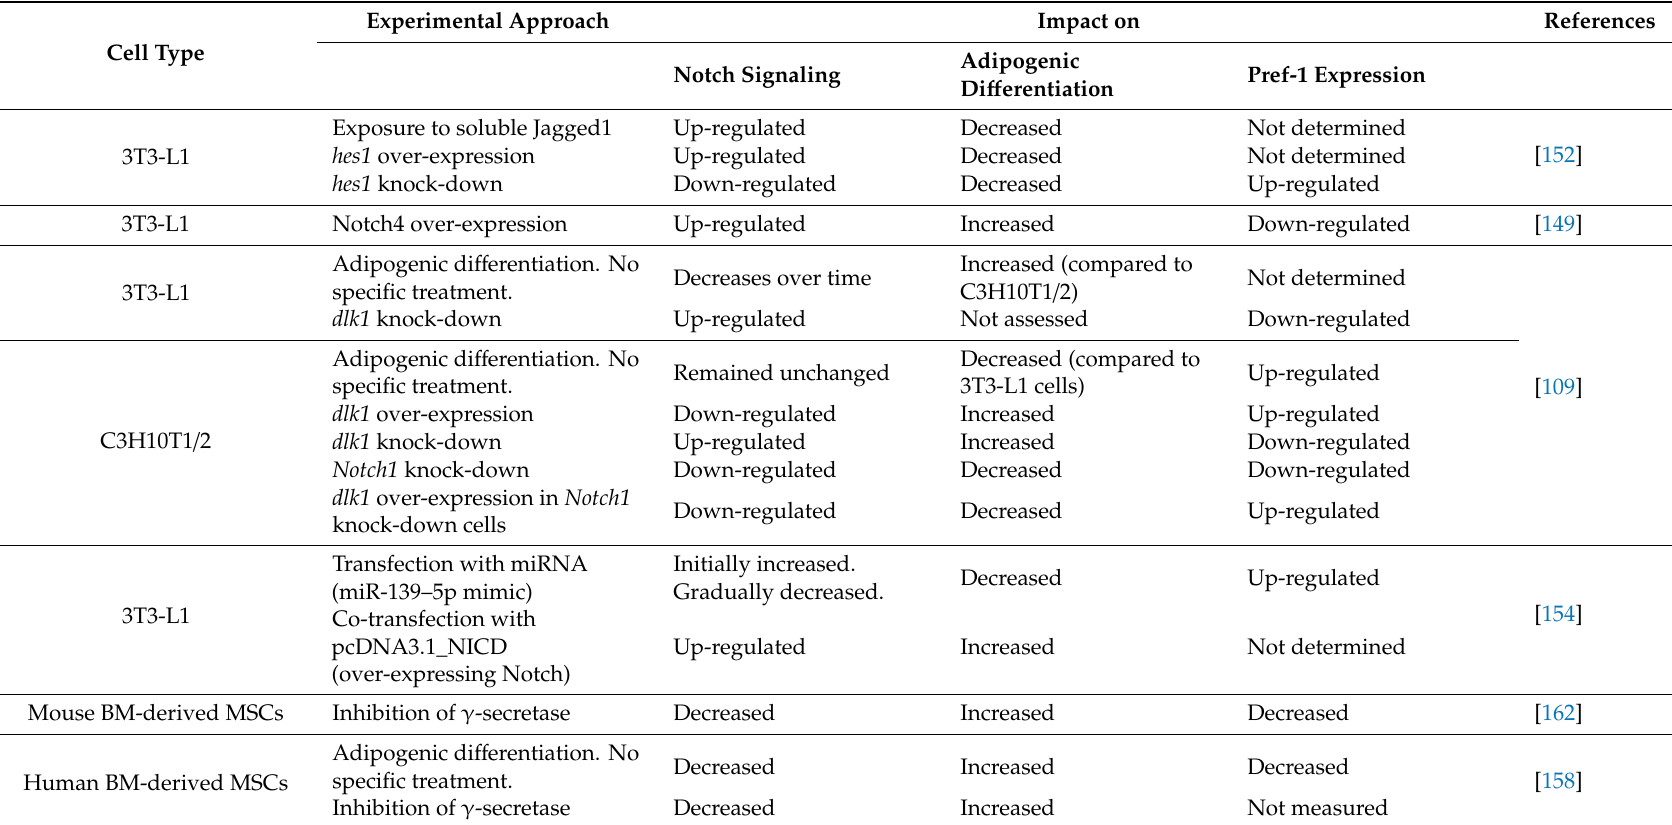
Table 2. Summary of the impact of Notch signaling on Pref-1 expression and adipogenic di ff